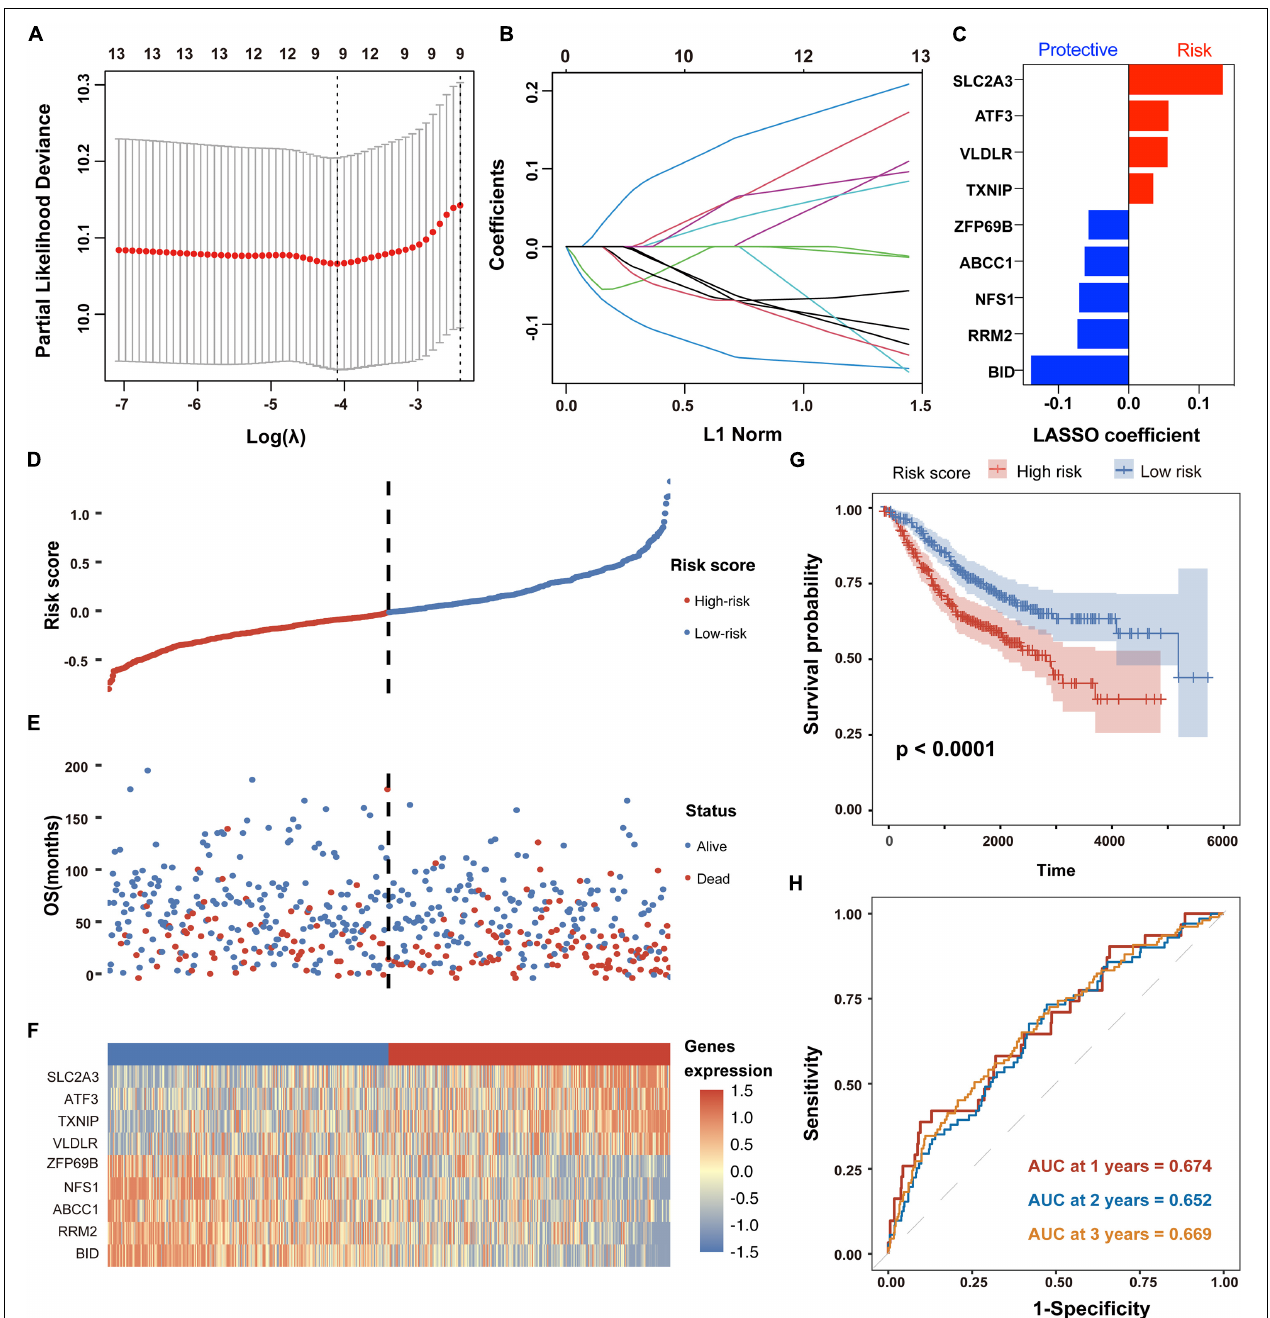
FIGURE 3 | Establishment and prognostic analysis of the FRG signature in CC. (A,B) The LASSO Cox regression analysis was employed to identify the most robust prognostic FRGs, with the optimal λ value of 0.0166. (C) Distribution of LASSO Cox coefficients of nine FRGs that constitute the prognostic signature. (D) Distribution of risk scores based on the FRG prognostic signature in the GSE39582 dataset. (E) Survival status of CC patients with high or low risk scores in the GSE39582 dataset. (F) Heatmap shows the expression pattern of nine FRGs that constitute the prognostic signature in the GSE39582 dataset. (G) Kaplan-Meier plot for overall survival of CC patients in high- and low-risk groups in the GSE39582 dataset. (H) Time-dependent ROC curves for the prognostic performance of the FRG signature in the GSE39582 dataset.